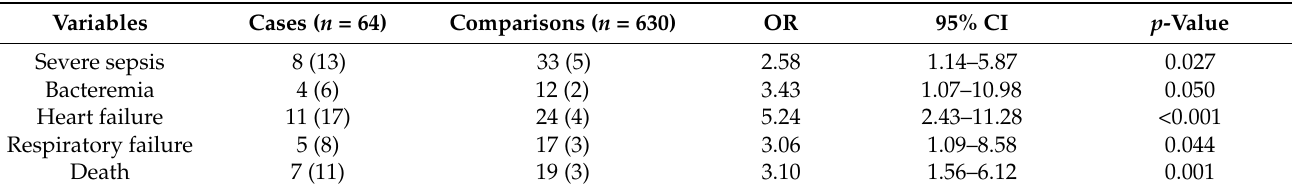
Table 2. Outcomes of hospitalized children between cases and comparisons.